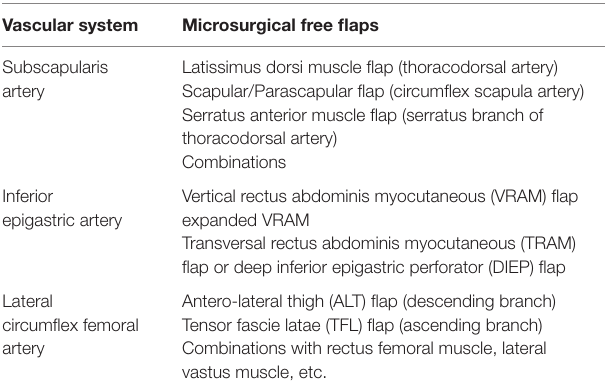
TABLe 2 | The most useful microsurgical free flaps for defect reconstruction of the pelvic region [modification of Beier et al. (3) and Das Gupta et al. (13)].